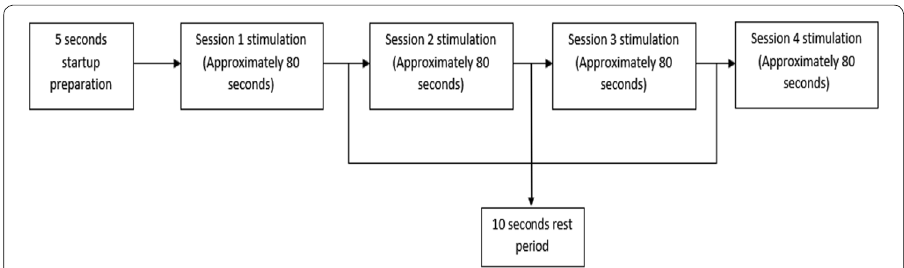
Fig. 1 Flow of the video presentation in the